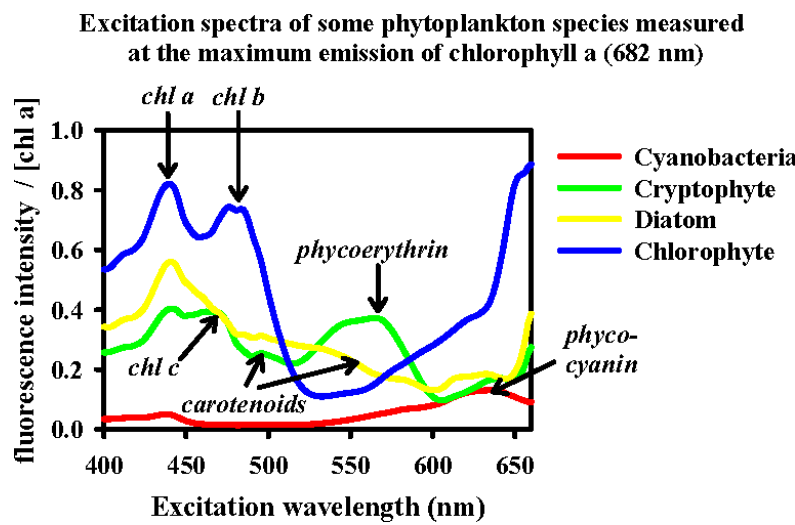
Figure 3. Fluorescence excitation spectra for different chemotaxonomic phytoplankton pigment groups. Reprinted with permission from [57]. Copyright 2003, International Council for the Explo- ration of the Sea